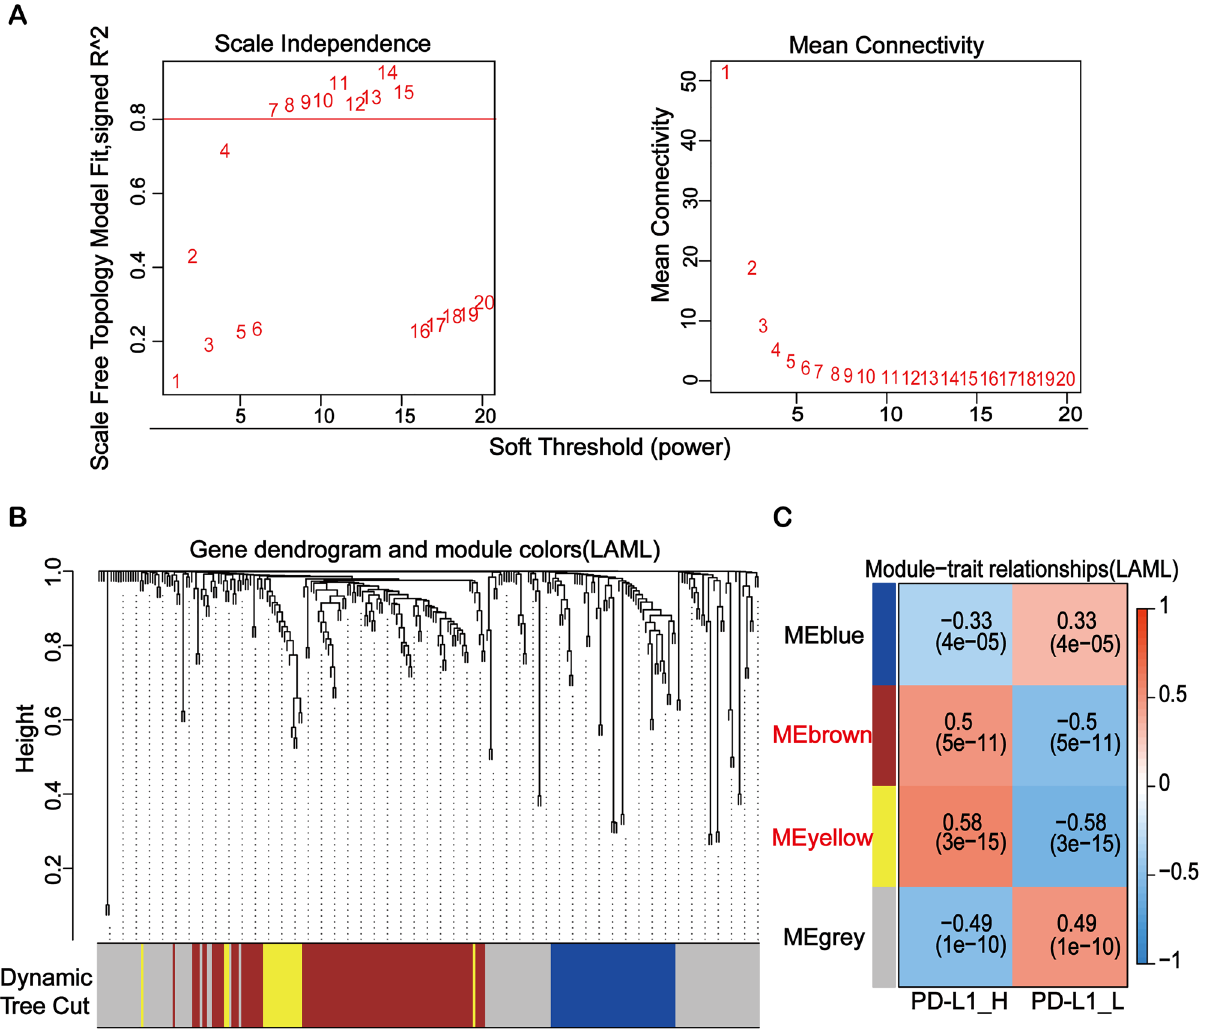
Figure 3. Identification of pivotal PD-L1-related modules using weighted gene co-expression network analysis. ( A ) Analysis of the mean connectivity and scale independence for adjusting soft-threshold powers. ( B ) The genes in topological overlap matrix were divided into gene sets by Dynamic Tree Cut, and four modules were generated. ( C ) Confirmation of four key modules of DEGs clustering and overview of the correlation between the modules and PD-L1